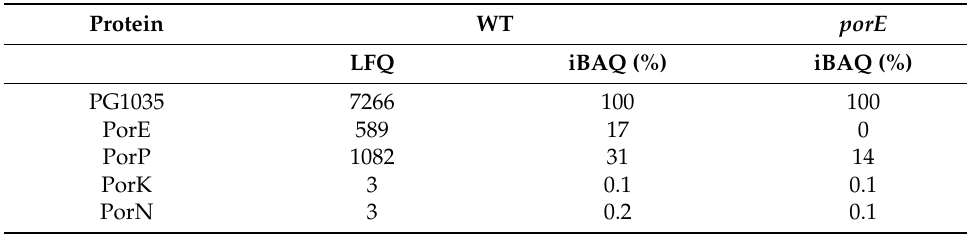
Table 1. PG1035 complexes in WT and porE mutant.